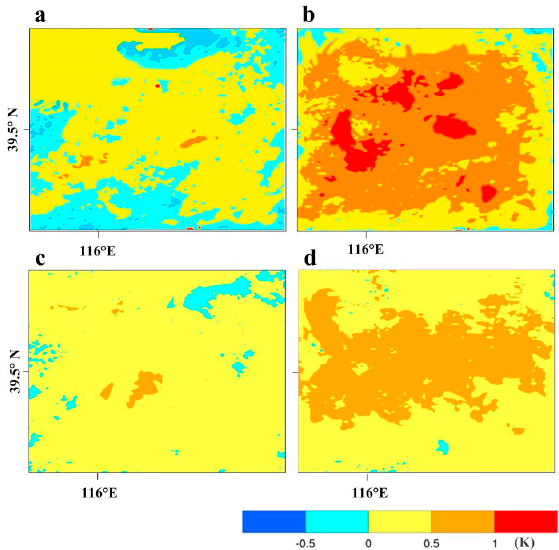
Figure 5. The temperature difference between different land cover during daytime and night. ( a ) and ( b ) are CU-NU and FU-CU during the daytime, respectively; ( c ) and ( d ) are CU-NU and FU-CU at night, respectively.